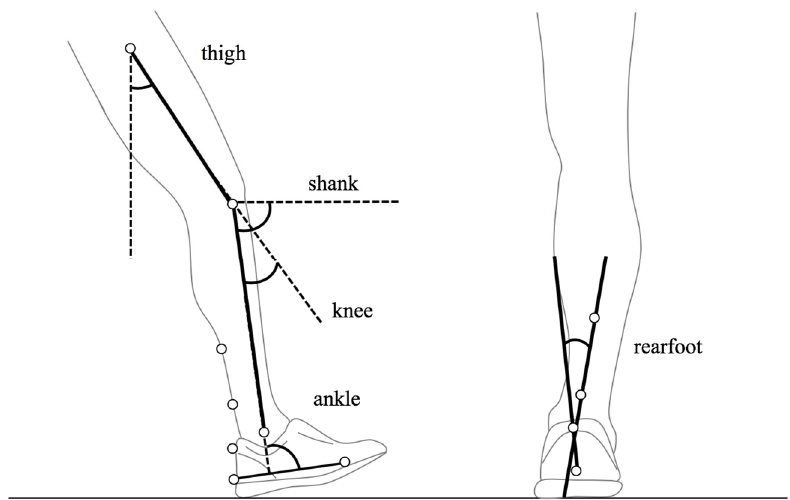
Figure 3. Conventions used for lower extremity angles. off, and maximum oscillation. Running phases and gait cycles were normalized to 100 data points. The stance was divided into absorption phase—from the initial contact to maximum knee flexion in the midstance—and generation phase—from maximum knee flexion to toe-off [29] (Figure 4).